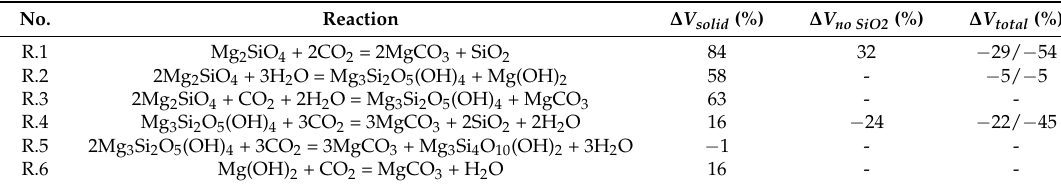
Table 5. Changes in free energy and estimated changes in solid volume and total volume for the main reactions expected to occur during peridotite hydration/carbonation at constant temperature. Negative volume changes indicate a volume decrease. Changes in Gibbs free energy are given at standard reference conditions ( ∆ G f , RTP at 298.15 K and 0.1 MPa) and at 423 K (150 ◦ C) and 50 MPa hydrostatic pressure (~1.5 km depth − ∆ G f , HTP ). Volume changes given are changes in solid volume only ( ∆ V solid ), changes in solid volume without precipitation of silica ( ∆ V noSiO 2 ), and changes in total volume, including solids and fluids ( ∆ V total ). In the latter case, values are given assuming one-phase flow and two-phase flow. Solid molar volumes are not corrected for temperature and pressure. Fluid molar volumes (for total volume changes) are calculated for a saturated CO 2 solution at 423 K and 50